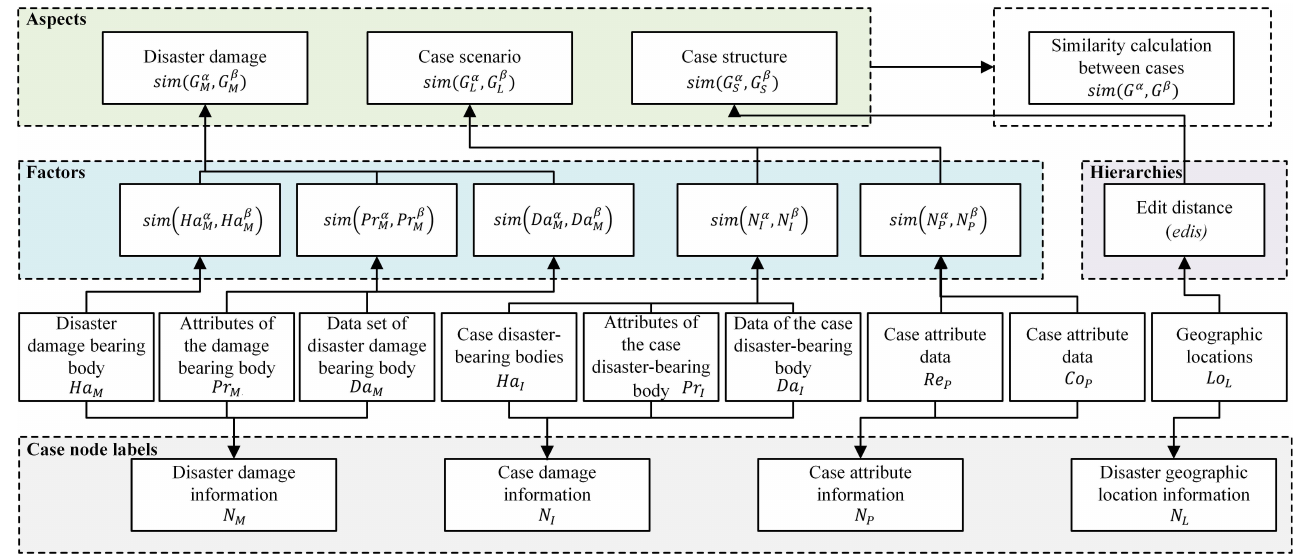
Figure 3. Architecture of the similarity model between natural disaster